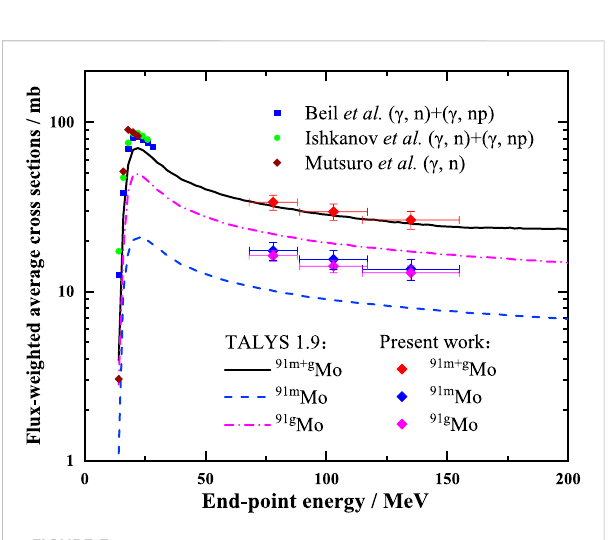
FIGURE 3 Experimental results of 92 Mo( γ , n) 91m,g Mo reaction FACSs, comparing with previous works [31 – 33] and TALYS 1.9 calculations.